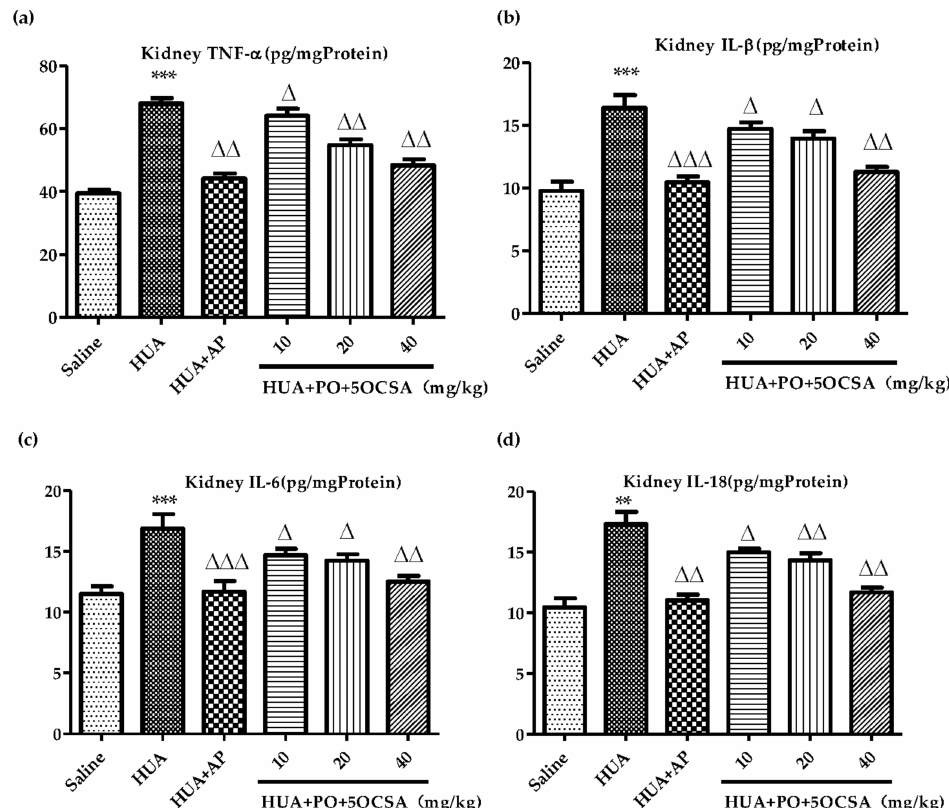
Figure 6. Effects of 5OCSA on kidney inflammation cytokines in HUA mice. ( a ) TNF- α (pg/mg Pro- tein); ( b ) IL-1 β (pg/mg Protein); ( c ) IL-6 (pg/mg Protein); ( d ) IL-18 (pg/mg Protein). Data are represented as mean ± SD (n = 8). ** p < 0.01, *** p < 0.005, compared with saline group; ∆ p < 0.05; ∆∆ p < 0.01, ∆∆∆ p < 0.005, compared with HUA group. TNF- α : tumor necrosis factor- α ; IL-1 β : interleukin-1 β ; IL-6: interleukin-6; IL-18: